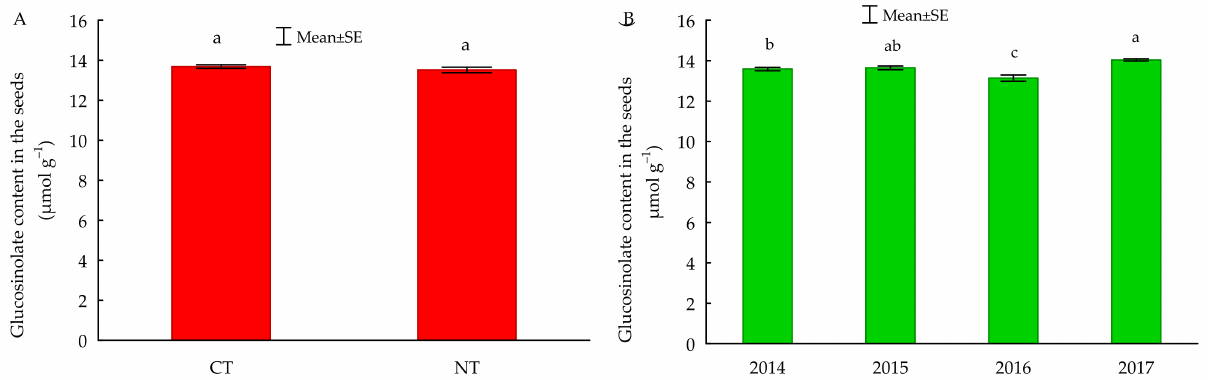
Figure 4. Glucosinolate content in winter oilseed rape seeds depending on the tillage system ( A ) (mean for 2014–2017) and years of research ( B ). CT—Conventional tillage; NT—No-tillage. Different letters denote significant differences ( p ≤ 0.05). The same letter means not significantly different